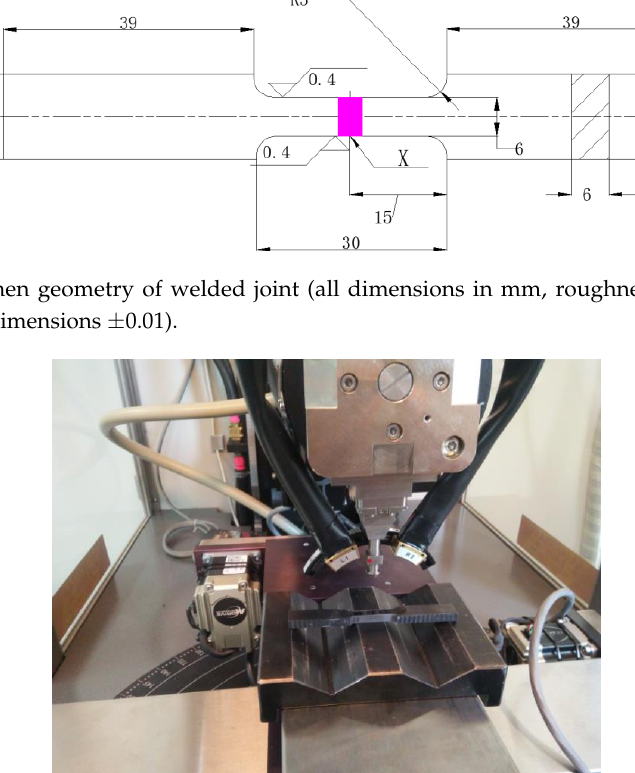
Figure 1. Specimen geometry of welded joint (all dimensions in mm, roughness in micrometers, tolerance for all dimensions ±0.01).